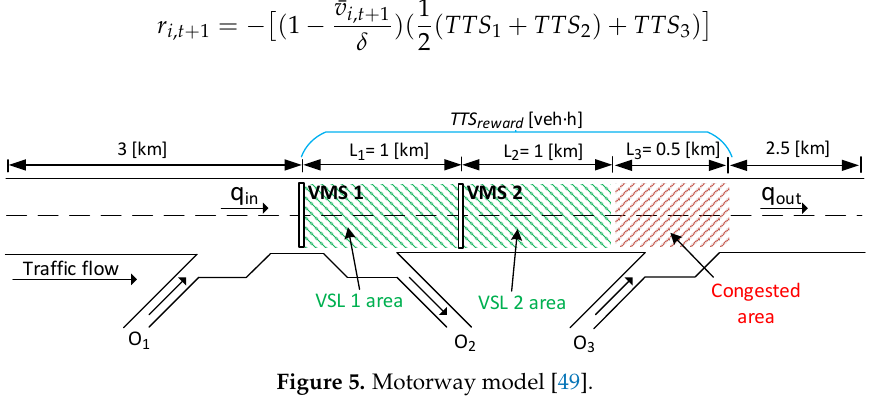
Figure 5. Motorway model